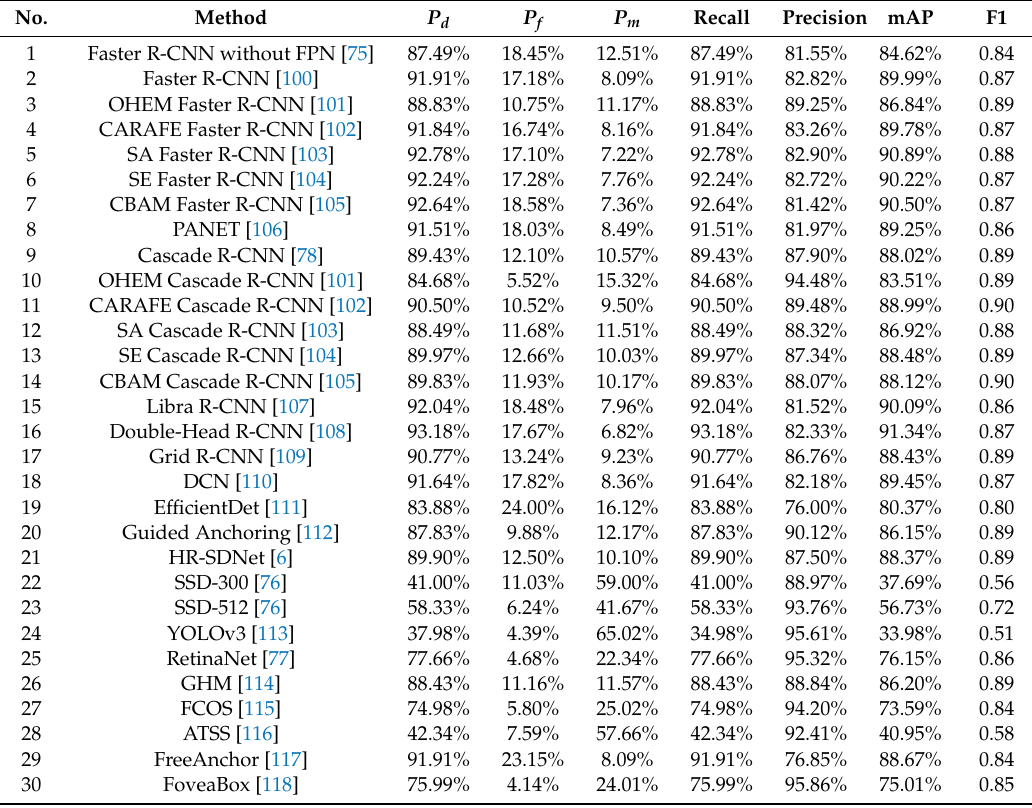
Table 11. Research baselines of the o ff shore